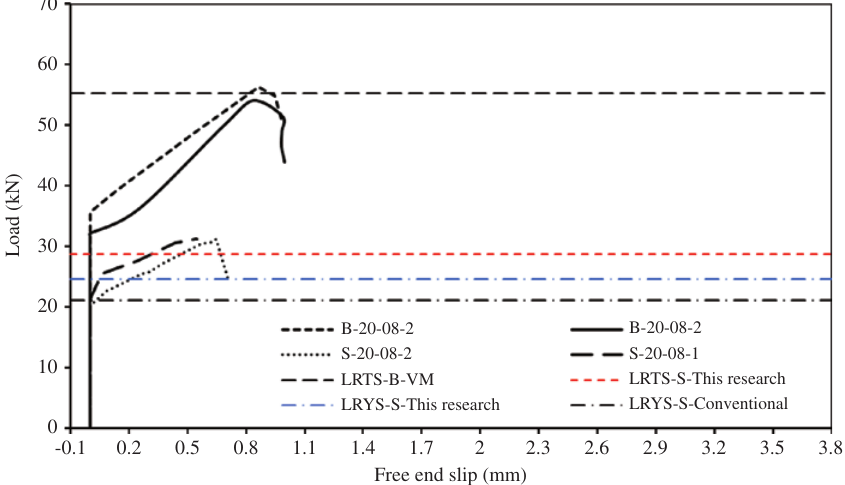
Figure 10: Load and free end slip relationship of 8 mm reinforcement bars and concrete (20 Φ embedment